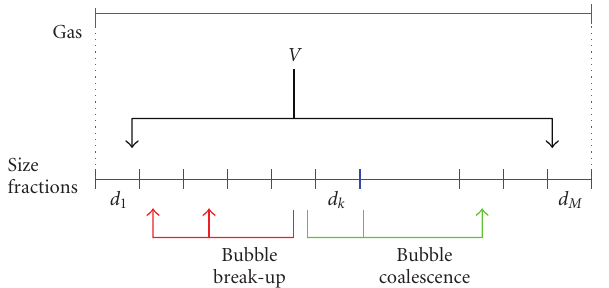
Figure 1: Scheme of the standard MUSIG model: all size fractions representing di ff erent bubble sizes move with the same velocity field.